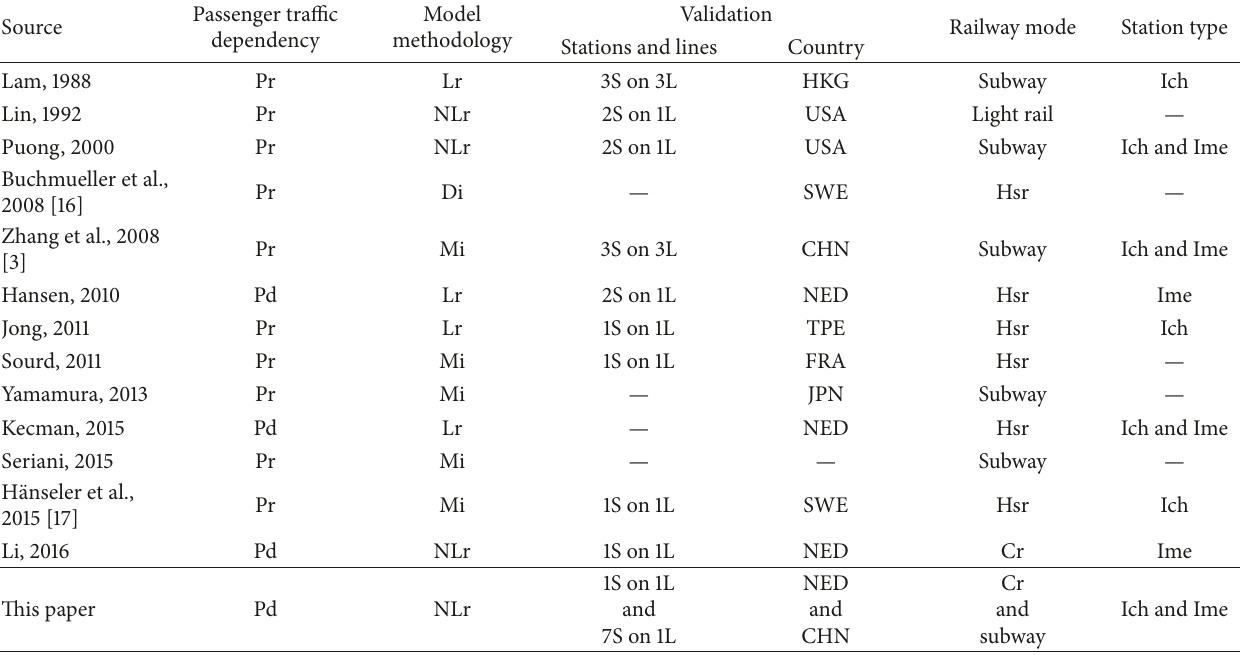
Table 1: Main features of existing dwell time estimation